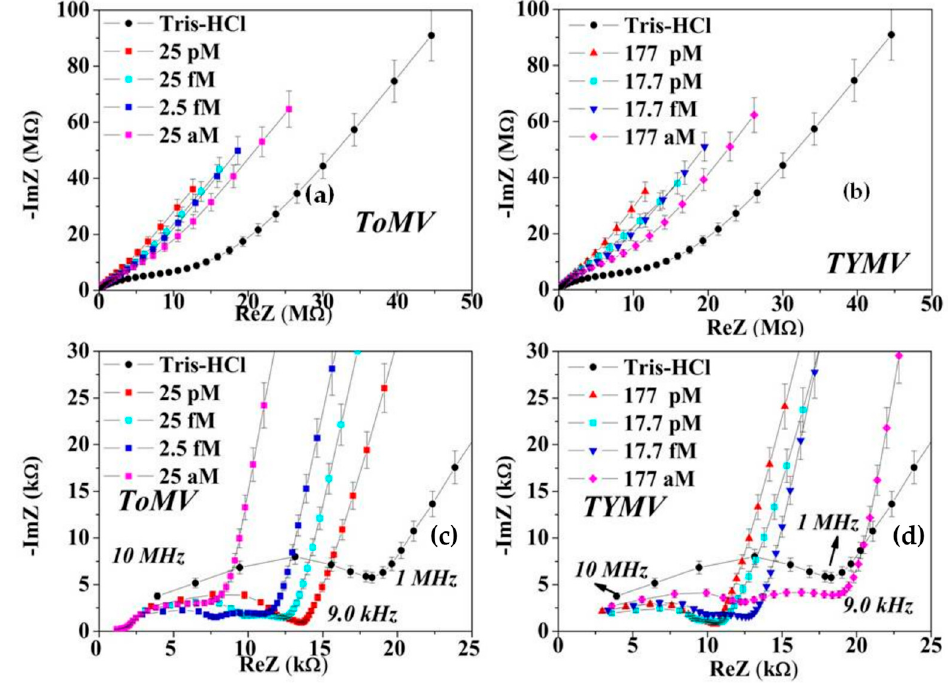
Figure 2. ( a , b ) Averaged NPs at V DC = 0.0 V extracted from Z vs f spectra between 0.1 Hz and 10 MHz at four representative virus concentrations for ToMV and TYMV-in TRIS-HCl droplet suspension. ( c , d ) Detail of the data range in ( a , b ) in the higher frequency region. The frequency corresponding to the onset of the anomalous diffusion was 9.0 kHz in both virus-based suspensions and at all molar concentrations.